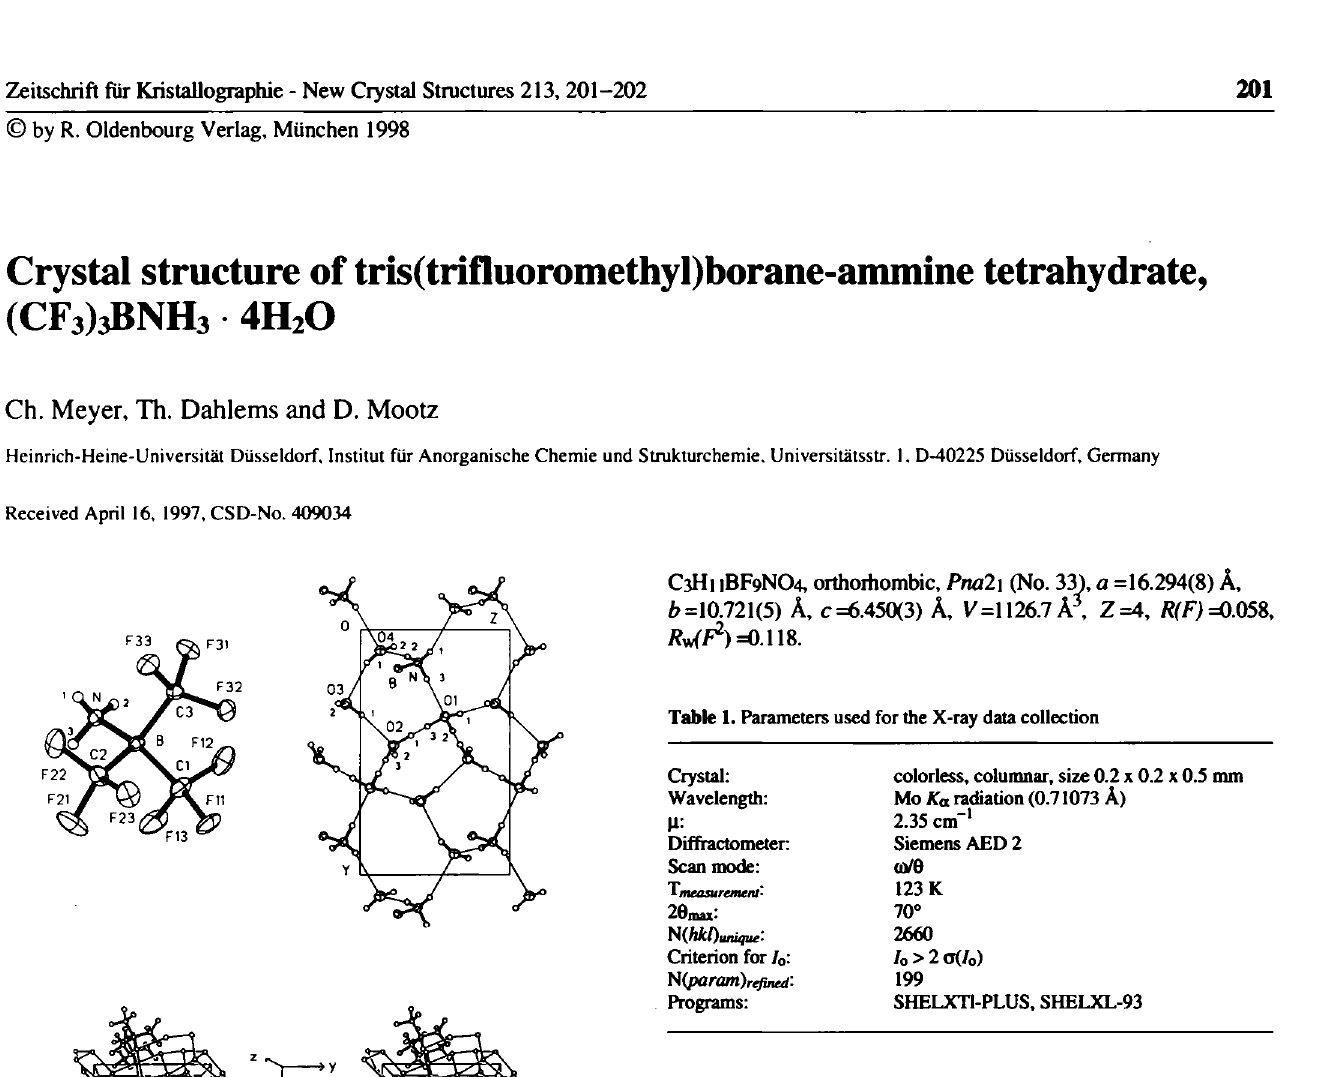
Table 2. Fmal atomic coordinates and displacement parameters (in